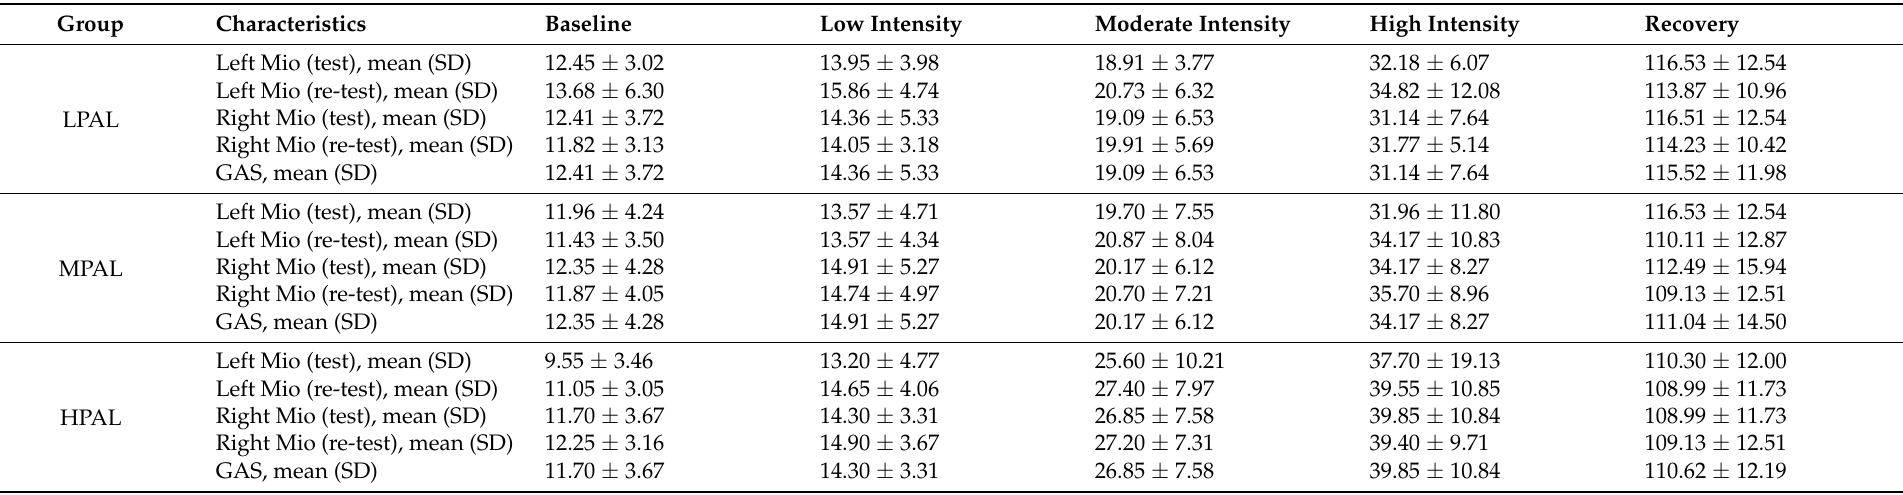
Table 3. Descriptive EE statistics for